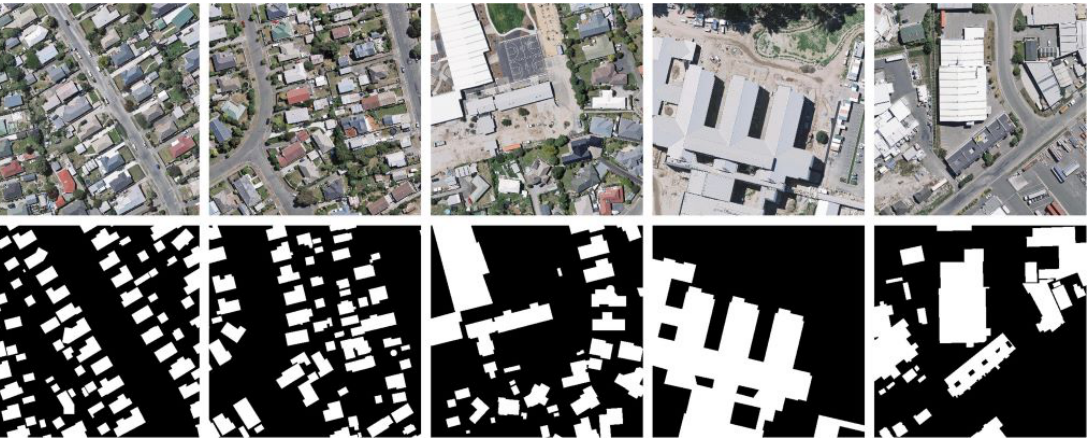
Figure 3. Some examples of the WHU Building Dataset. The first row is the original image and the second row is the ground